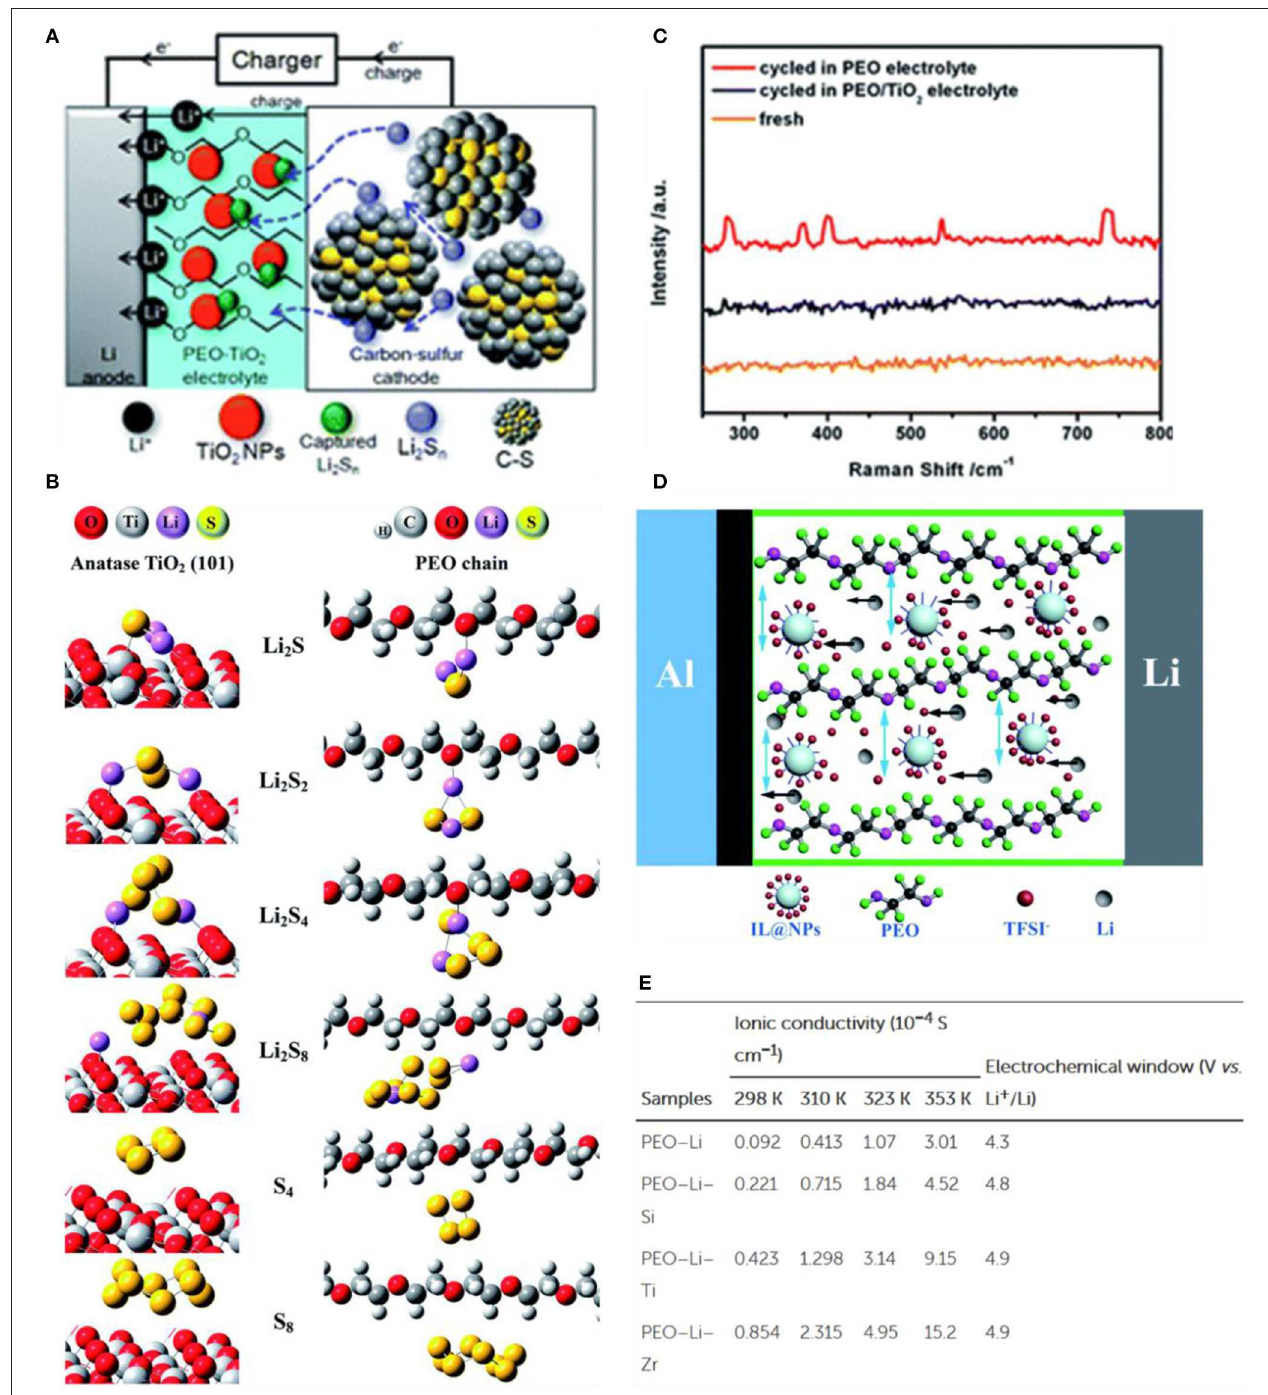
FIGURE 3 | Solid polymer electrolyte. (A) Equivalent circuit for impedance simulation and impedance measurements on PEO and PEO/TiO 2 electrolytes after cycling. Reproduced with permission (Sheng et al., 2017). Copyright 2017, Journal of Materials Chemistry A. (B) The adsorption configuration of lithium polysulfide (Li 2 S n ) and sulfur species on the PEO chain and anatase-TiO 2 (101). (C) Raman spectra of the Li anode, PEO and PEO/TiO 2 electrolytes before and after cycling. (B,C) Reproduced with permission (Sheng et al., 2017). Copyright 2017, Journal of Materials Chemistry A. (D) Schematic illustration of the promotion of the lithium-ion transportation. (E) Ionic conductivities and electrochemical windows of polymer electrolytes. (D,E) Reproduced with permission (Zhang C. et al., 2015). Copyright 2017, Journal of Materials Chemistry A.